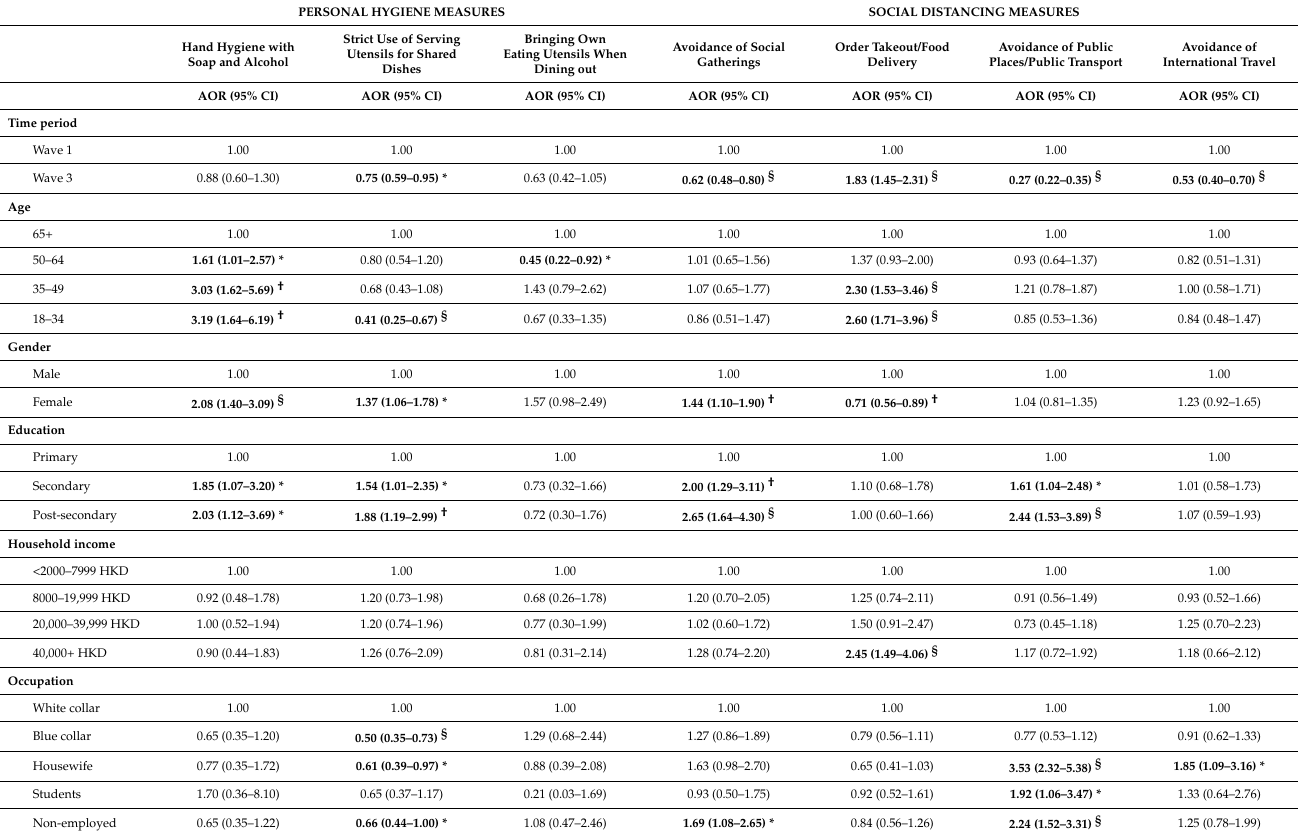
Table 3. Factors associated with compliance with personal hygiene and social distancing measures in Hong Kong COVID-19 1st wave and 3rd